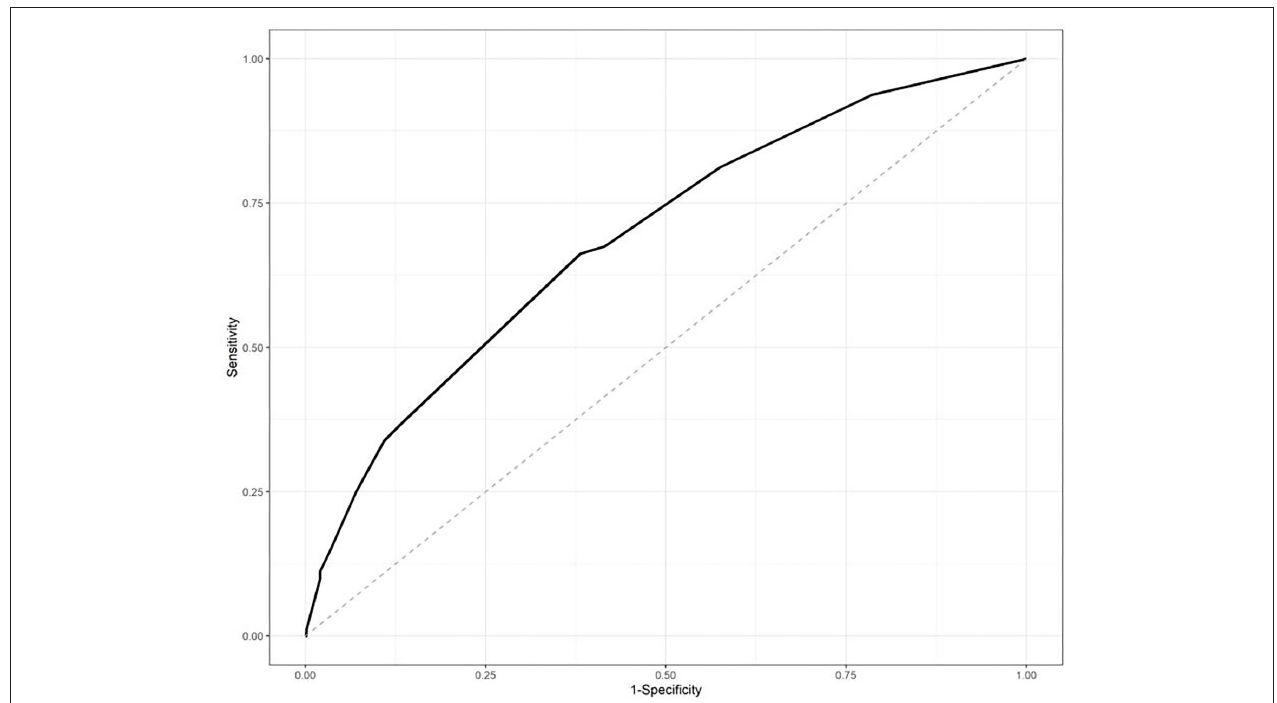
FIGURE 1 | Receiver-operator curve (ROC) analysis of the risk scores in the training datasets. The area under the curve was 0.6912.